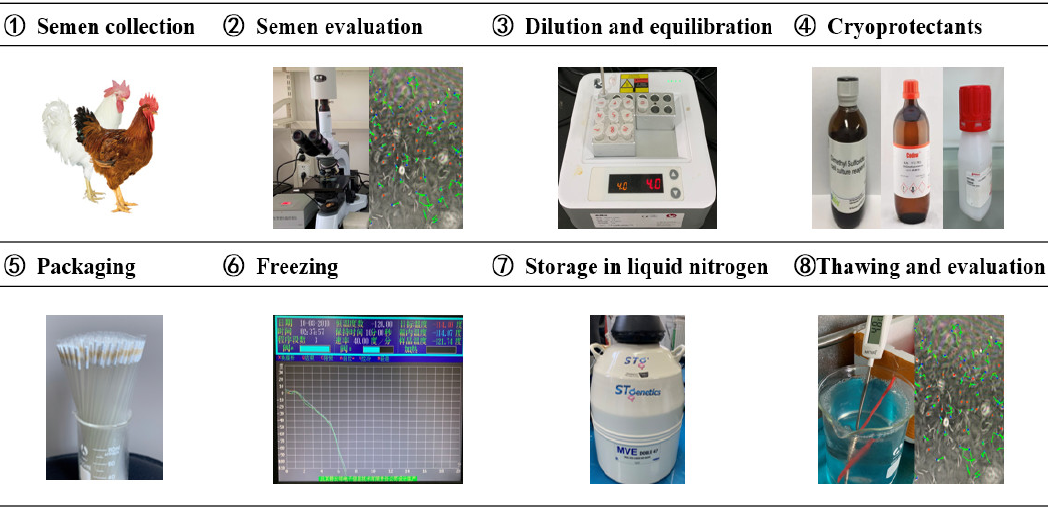
Figure 1. The structure of chicken sperm (scanning electron microscope, Hitachi SU8010, Japan. Scale bar = 20 um at 10,000× magnification).